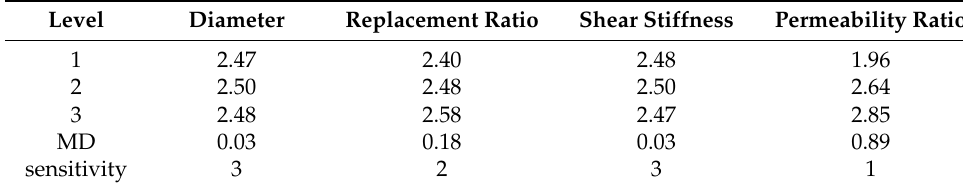
Table 5. Range analysis on PGA (m · s − 2 ).